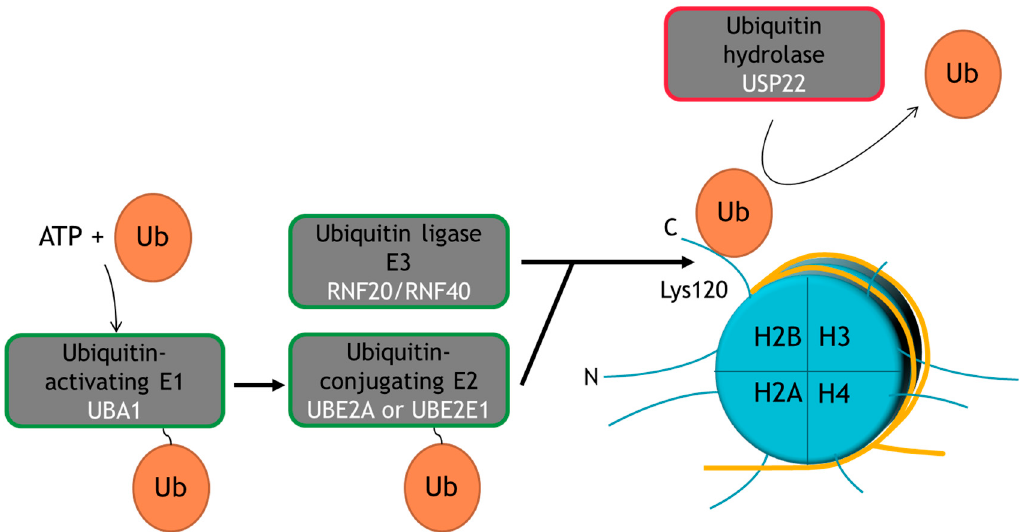
Figure 1. Schematic depiction of the enzymatic machinery catalyzing the addition and removal of H2Bub1. Ubiquitination requires cooperation between a ubiquitin-activating enzyme (E1), a ubiquitin-conjugating enzyme (E2) and a ubiquitin ligase (E3). The ubiquitin (Ub) can be removed from the target protein by ubiquitin hydrolases, like USP22. For illustrative purposes, the enzymes regulating H2Bub1 abundance are indicated.